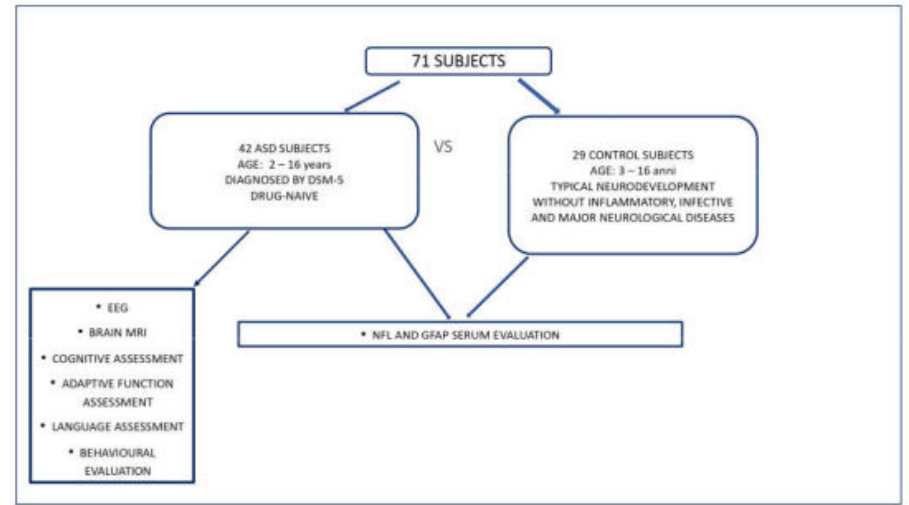
Figure 2. Workflow of the assessment of this